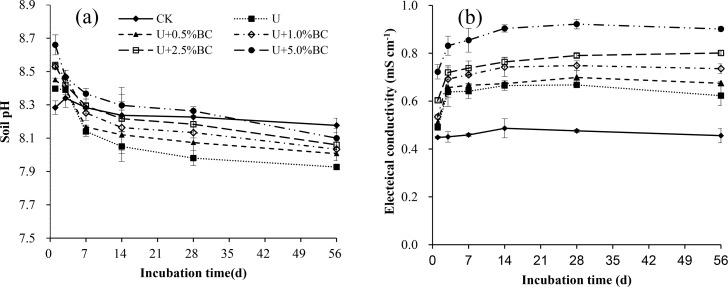
Dynamic variation of soil pH (a) and electrical conductivity (b) in different treatments over a 56-day incubation. Vertical bars in the figures represent standard error of the means (n = 3).